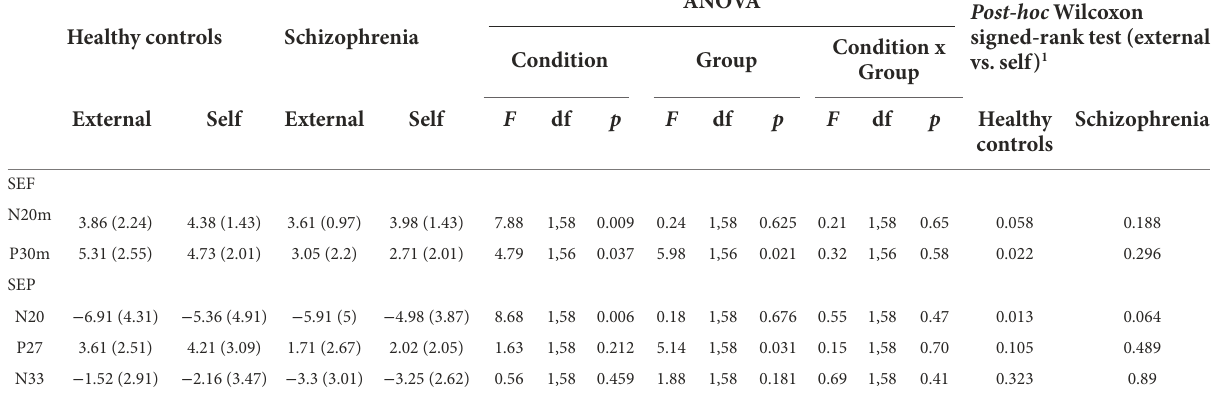
TABLE 2 Results of ANOVA Wilcoxon signed-rank test for N20 and P30 (external vs. self-conditions).